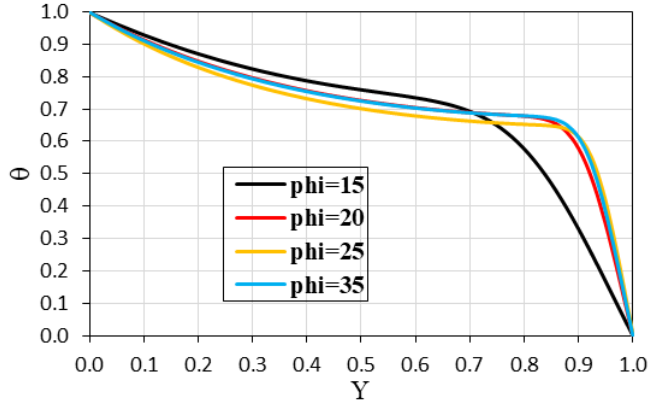
Fig. 8. Temperature along the centerline at X=0.5L of the roof pitch enclosures.